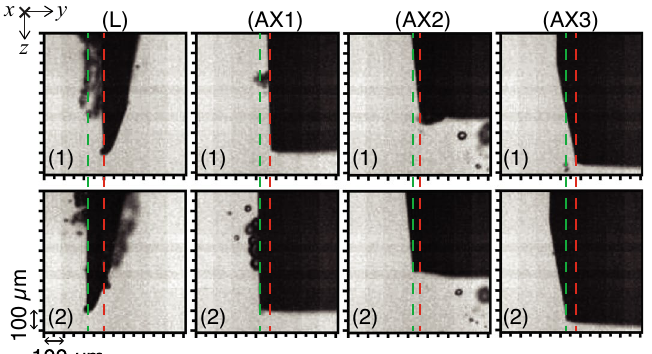
Figure 13. Typical high-speed camera shadowgraphs showing the peak-to-peak tip deflection (green and red dashed lines) for the lancet (L) and axi-symmetric tips (AX1–3), in water (depth 20 mm), during a half-cycle, at excitation frequency f 2 (sampling frequency 310 kHz). Captured greyscale images measured 128 × 128 pixels and the pixel size was 5 µm. A video can be found in Supplementary ≈